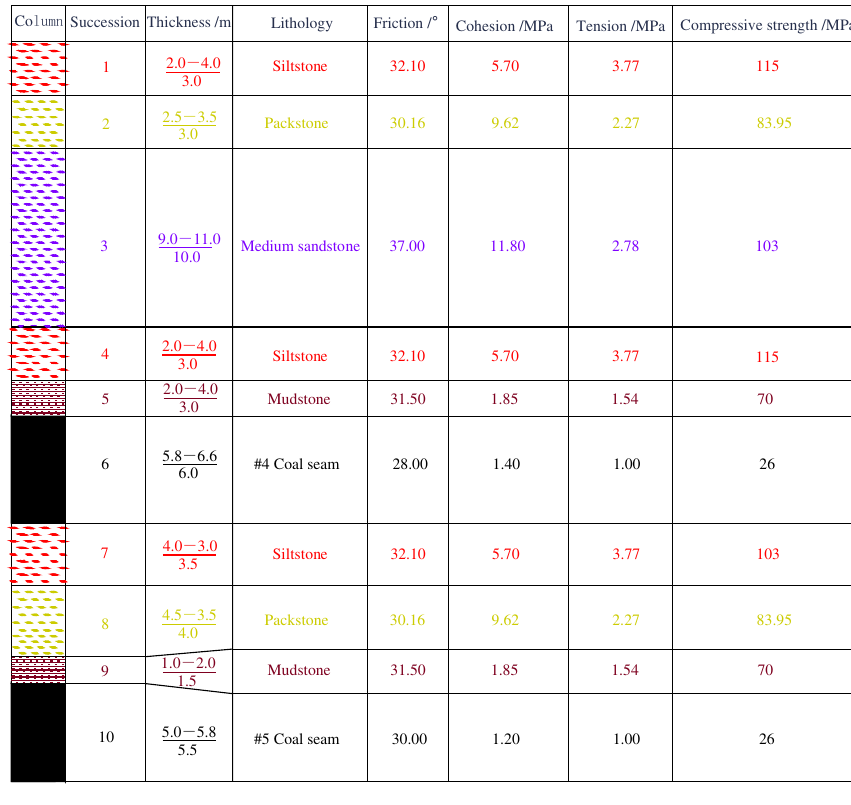
Figure 1. Lithology